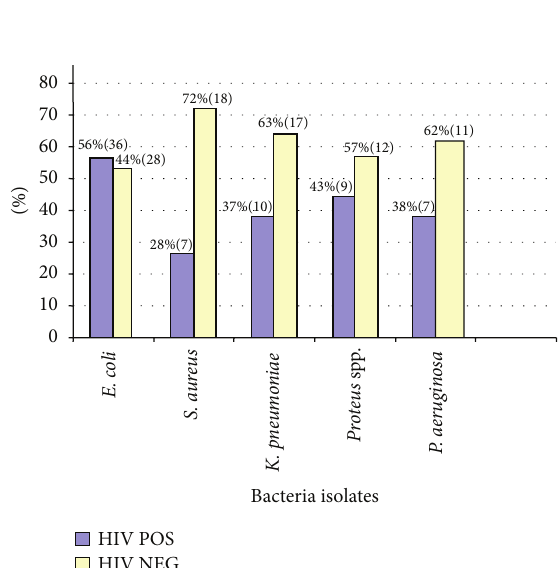
Figure 2: Distribution of bacteria isolates in relation to HIV